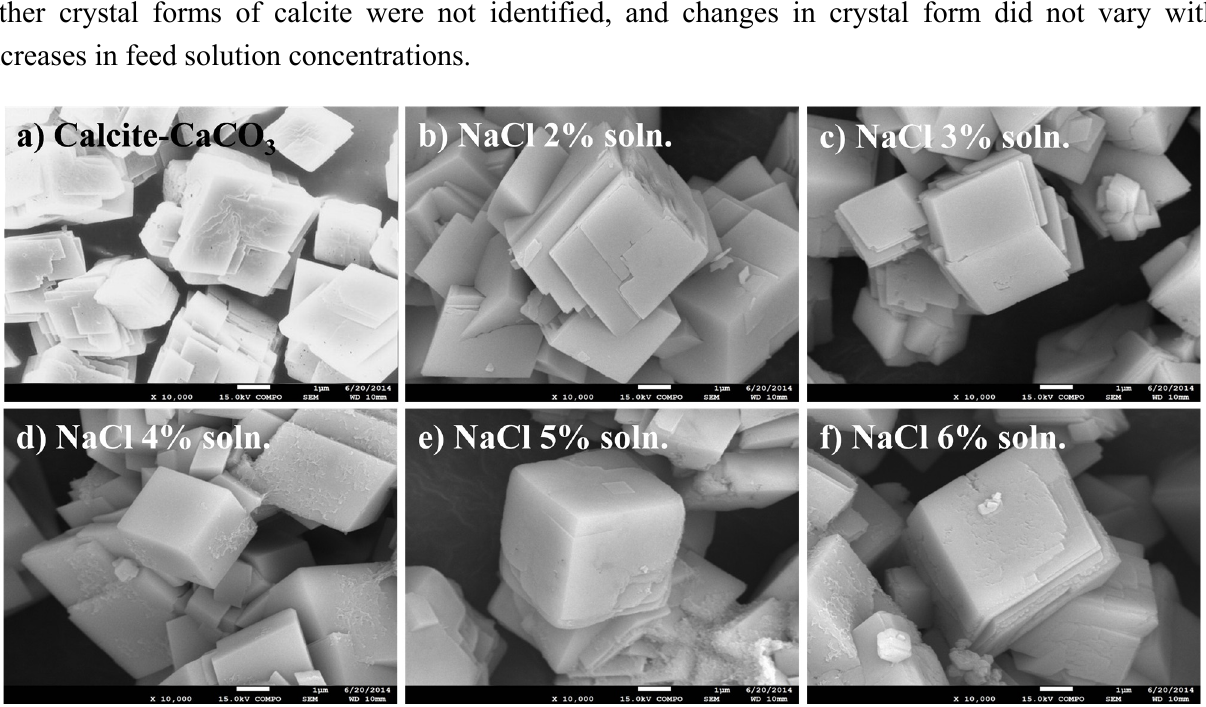
Figure 5. SEM images of the sample precipitated by the carbonation. (×10,000) ( a ) Calcite-CaCO 3 ; ( b ) NaCl 2% soln; ( c ) NaCl 3% soln; ( d ) NaCl 4% soln; ( e ) NaCl 5% soln; ( f ) NaCl 6%